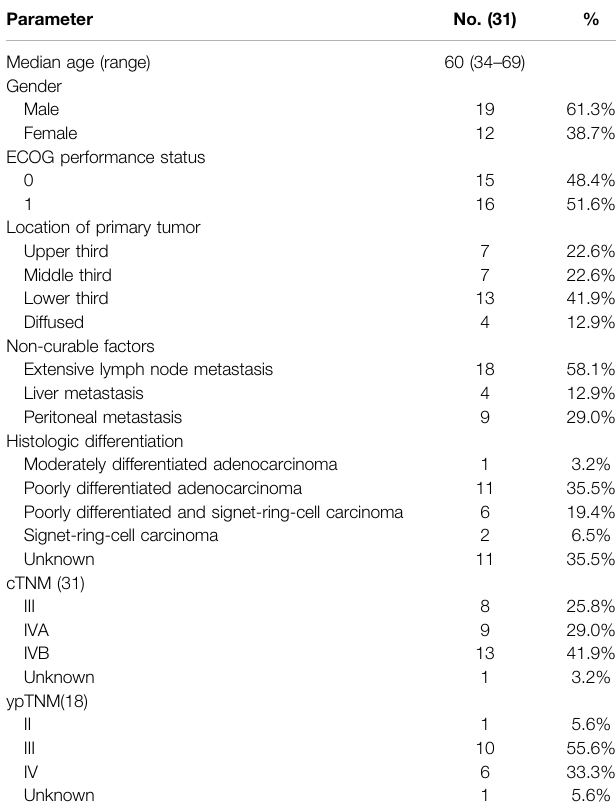
FIGURE 1 | Flow diagram. TABLE 1 | Patient